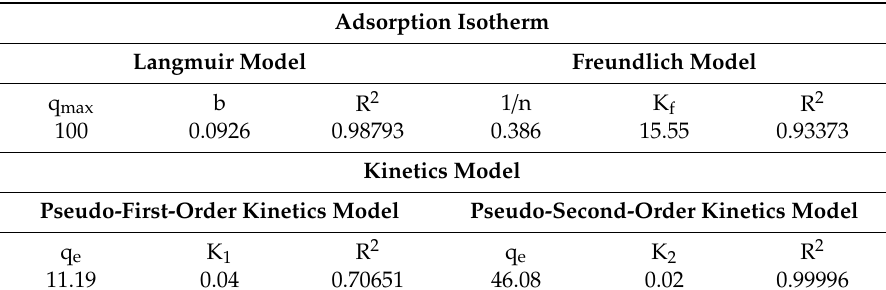
Table 2. Constants and correlation coe ffi cients of the isotherm and kinetics models.